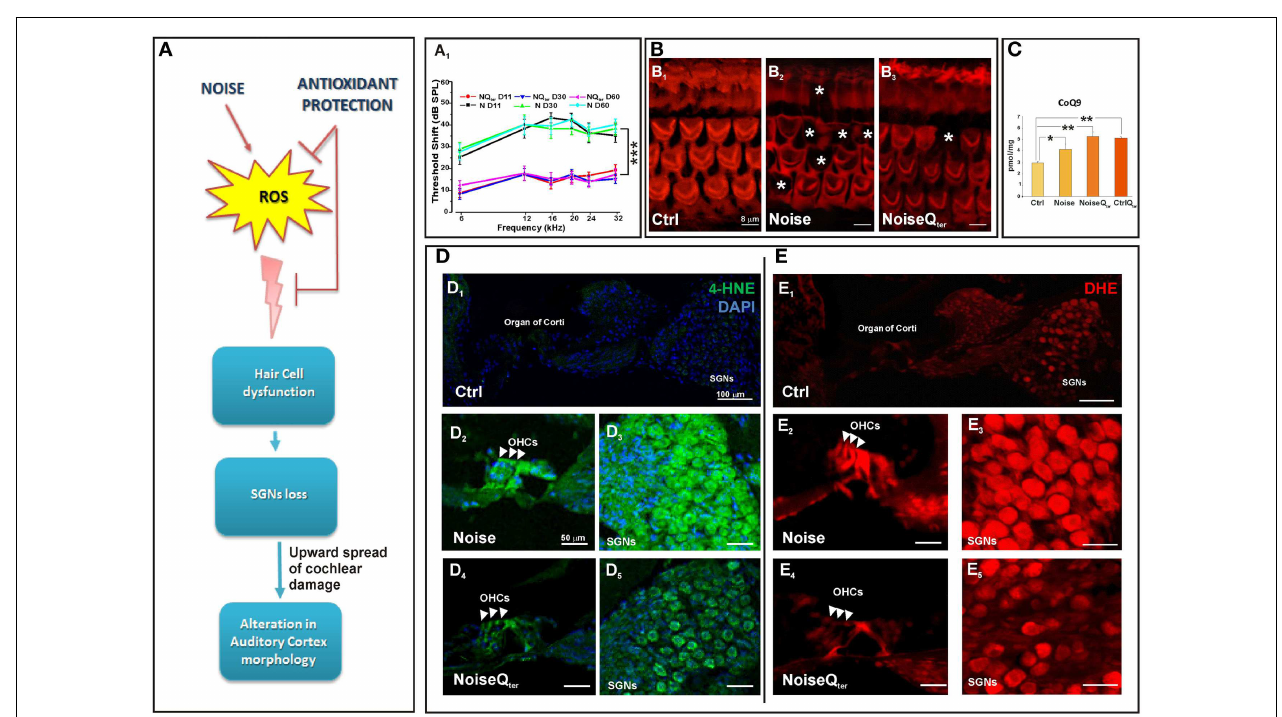
in three rows of OHCs and one row of inner hair cells (IHCs) is shown [indicated by asterisks in (B 1 )], in noise exposed animals HC loss is observed mainly in the middle and basal turn [indicated by asterisks in (B 2 )].The amount of HC disappearance is significantly decreased by antioxidant treatment (B 3 ). (C) In order to demonstrate that the CoQ analog is protective against oxidative stress in the cochlea, the quantification of quinone levels (CoQ 9 ) has been performed by HPLC analysis at the end of Q ter treatment. Interestingly, rats treated with Q ter show higher quinone levels than in Ctrl and noise groups.The cochlear oxidative damage after noise exposure at day 11 has been detected using superoxide (D) and lipid peroxidation (E) markers. (D) Noise-induced superoxide production in the OHCs [indicated by arrow-heads in (D 2 ,D 4 )] and SGNs (D 3 ,D 5 ) is reduced by Q ter treatment. Similarly, Q ter treatment significantly decreases the expression of 4-HNE mainly in OHCs [indicated by arrow-heads in (E 2 ,E 4 )] and SGNs (E 3 ,E 5 ). Data are taken from Fetoni et al.